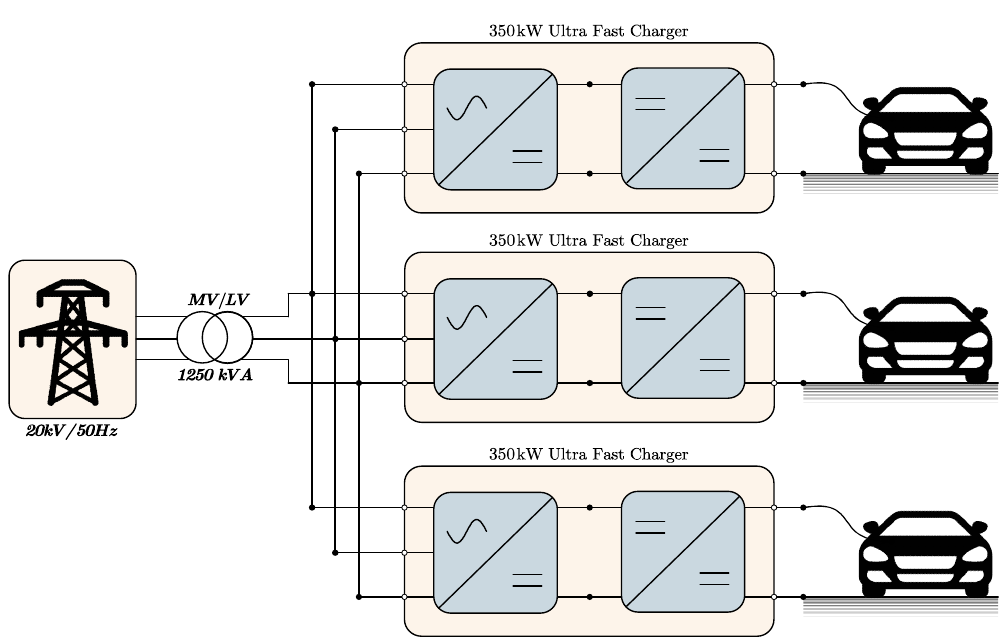
Figure 6. Three ultra-fast chargers isolated by a MV/LV transformer.